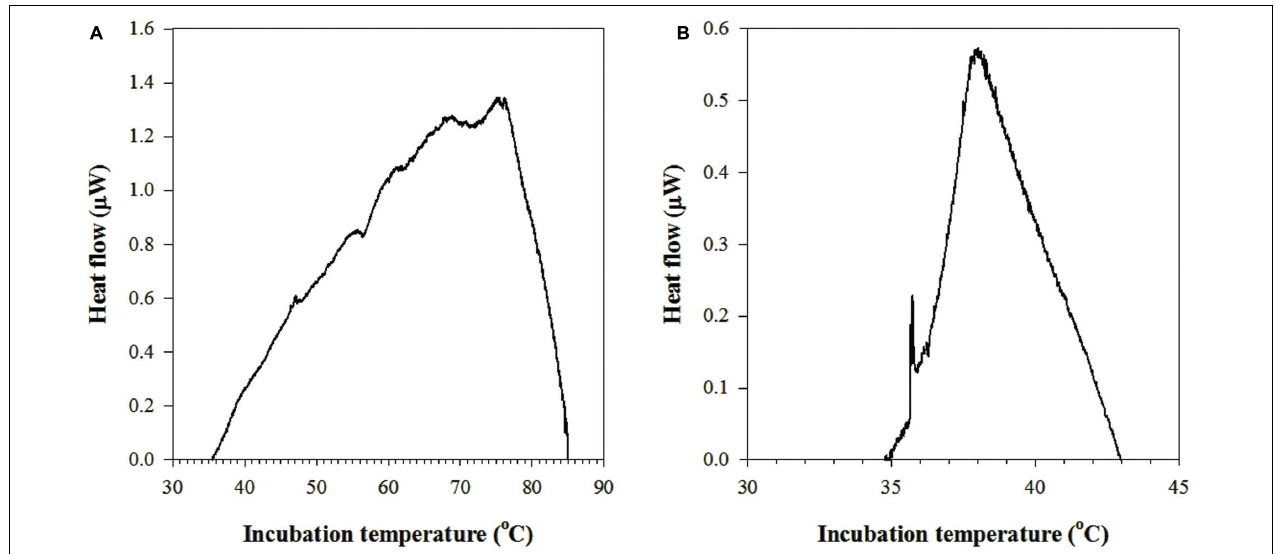
FIGURE 2 | Metabolic heat rates as a function of temperature as measured by two-step isothermal nanocalorimetry in subseafloor crustal fluids of (A) Juan de Fuca Ridge flank and (B) North Pond. An initial baseline correction was performed by subtracting blanks from sample heat-flow profiles. After identification of upper and lower temperatures of measurable metabolic heat rates, a second baseline correction was performed manually between these temperatures.